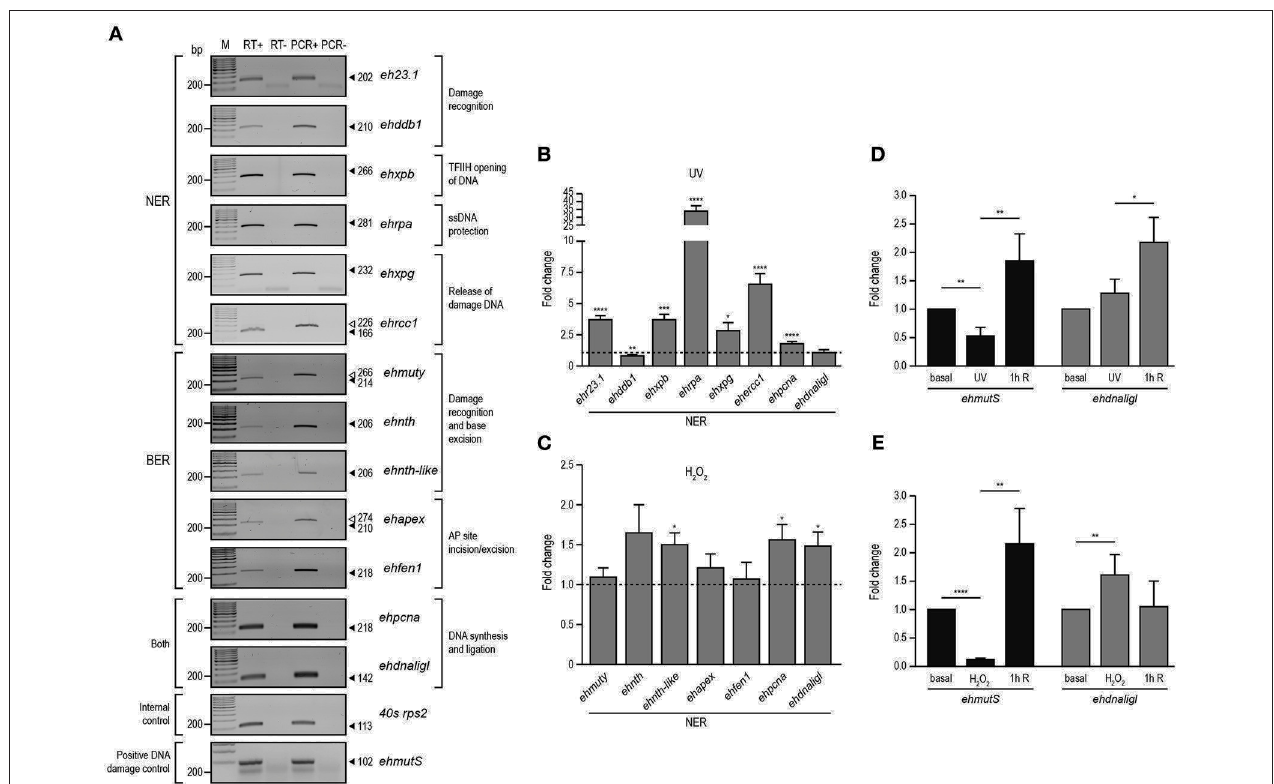
FIGURE 4 | Expression of NER and BER genes in E. histolytica . RT-PCR analysis of NER and BER genes in basal conditions. (A) Expression of NER and BER genes using RNA isolated from trophozoites in basal conditions by semi-quantitative RT-PCR experiments (RT + ). RT-: PCR assays using RNA without reverse transcriptase. PCR + : PCR assays using genomic DNA. PCR-: PCR experiments performed without genomic DNA. Arrowheads: expected size of the amplicons. qRT-PCR analysis of the NER (B) and BER (C) genes using RNA isolated from trophozoites treated with UV (150 J/m 2 ) or H 2 O 2 (2.5mM for 1h), respectively, compared with RNA obtained from trophozoites cultured in basal condition. (D,E) qRT-PCR analysis of ehmutS (positive DNA damage control) and ehdnaligI genes during basal, immediately treated and 1h recovery from UV (D) or H 2 O 2 (E) treatments. Fold change was determined using 40s rps2 as internal control gene. Data represent media ± standard error from three independent experiments. * p < 0.05, ** p < 0.01, *** p < 0.001, **** p <